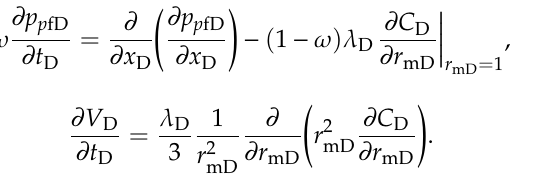
Figure 6. The influence of the fracture porosity on the curve of the non-equilibrium sorption model.